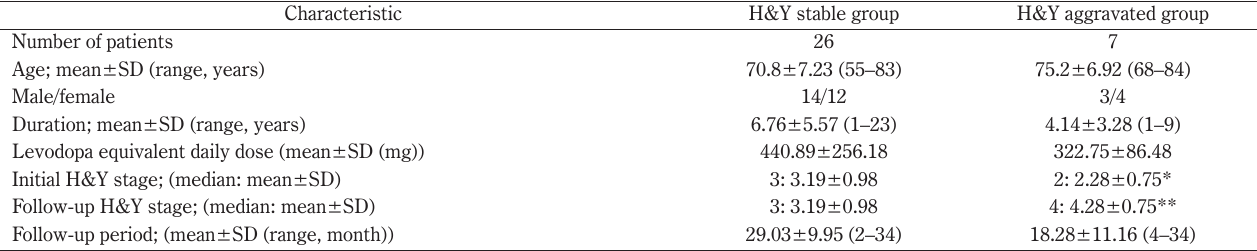
Table 3 Clinical features of Hoehn & Yahr stable and aggravated